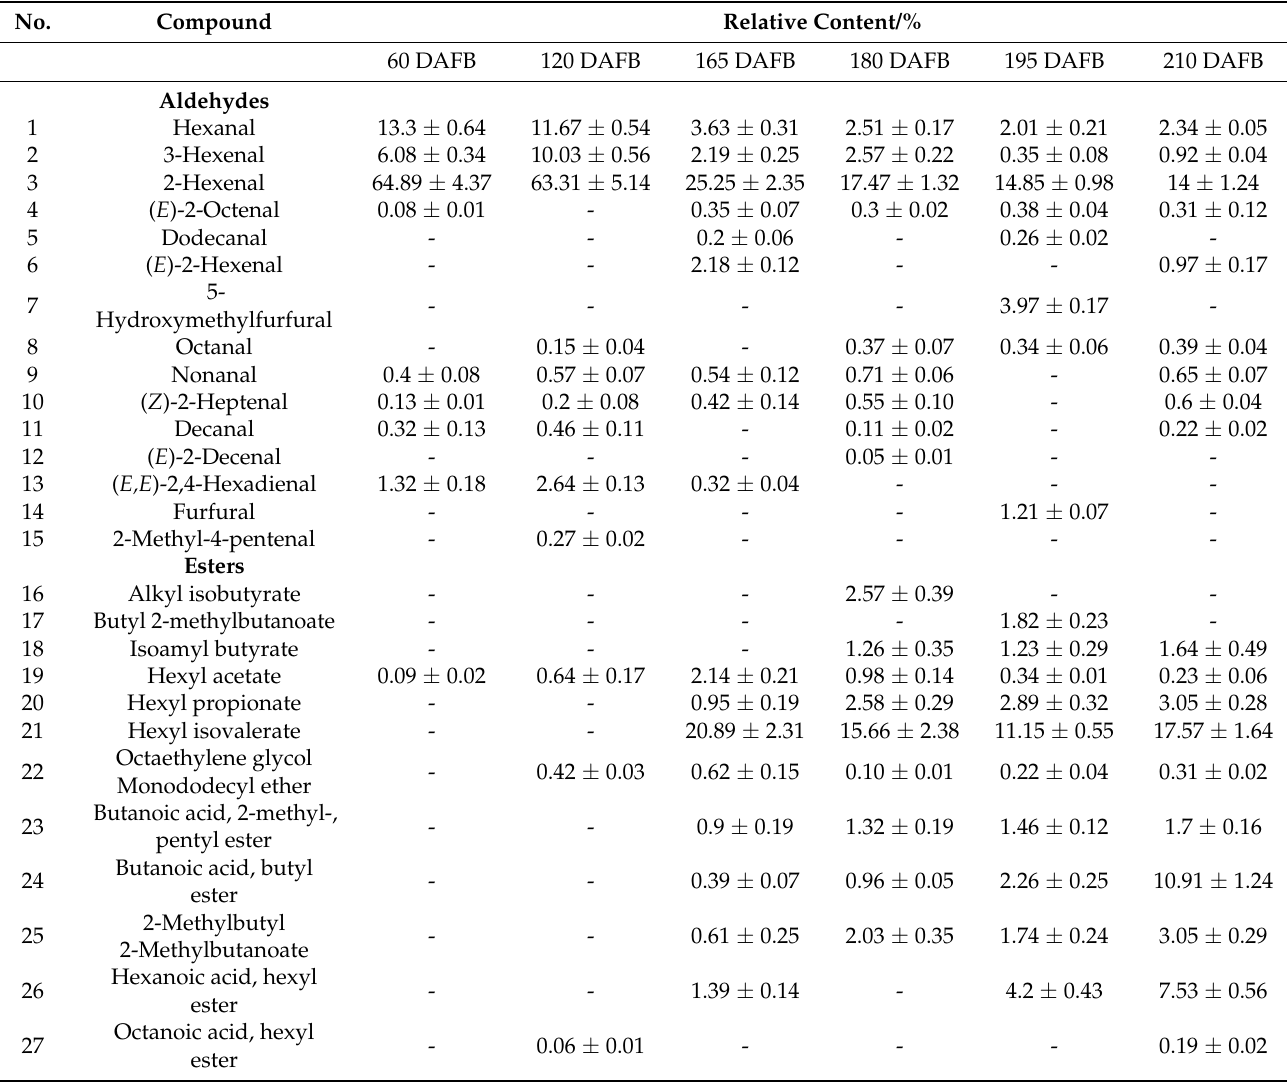
Table 1. Major volatile compounds detected in “Ruixue” apple fruit during different developmental stages (DAFB, days after full bloom).